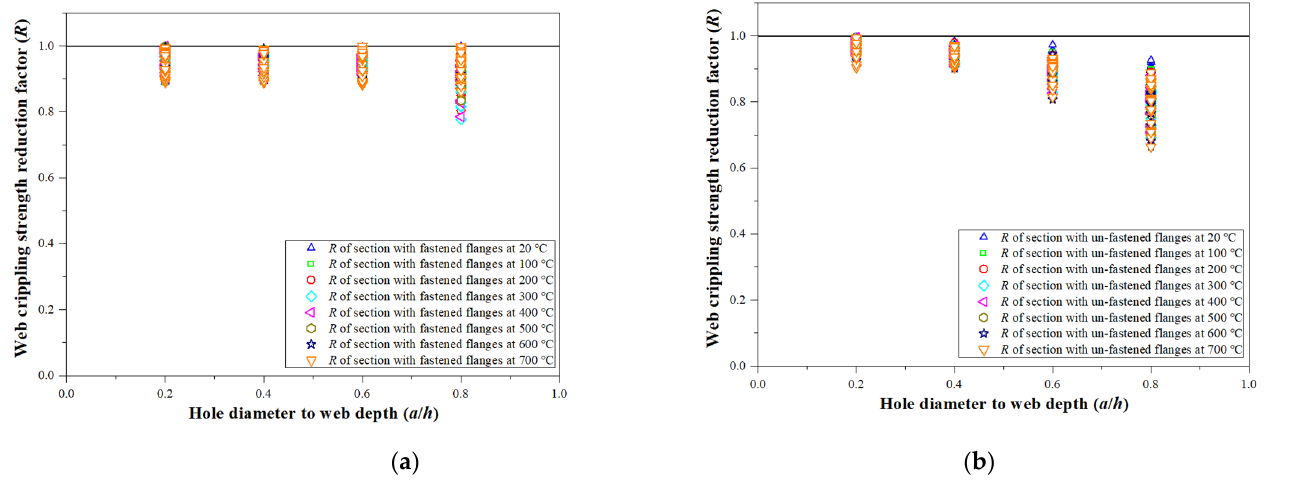
Figure 6. Load-displacement plot of selected sections under different temperatures for ( a ) unfastened section (100 × 30 × 15-t1.55-N50-A0.6-FR) with a centered hole and ( b ) fastened section (100 × 30 × 15-t1.55-N50-A0.6-FX) with a centered hole.